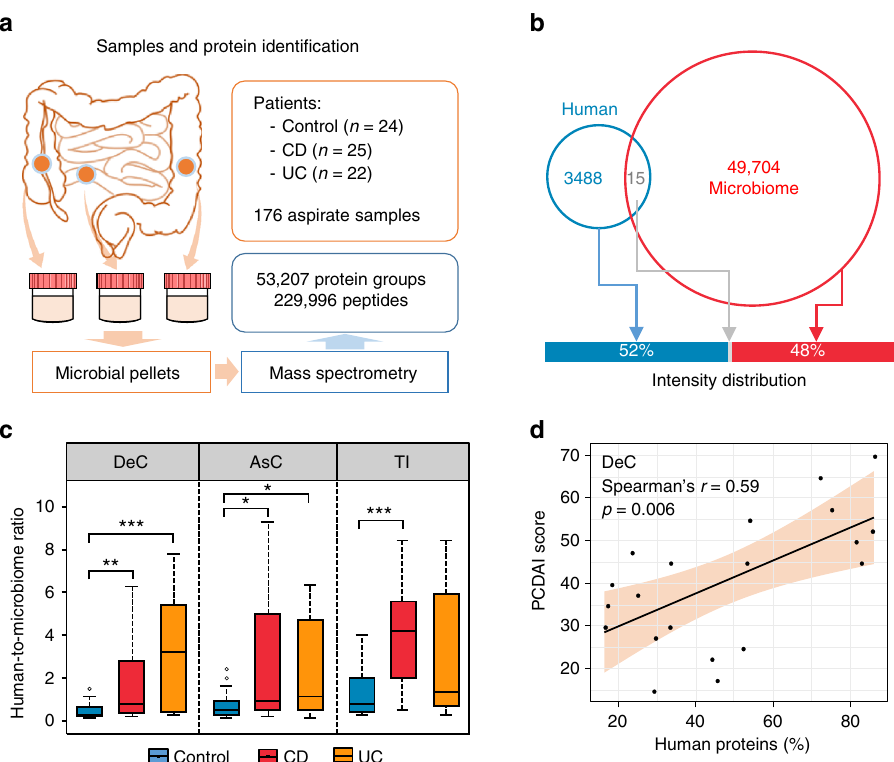
Fig. 1 Metaproteomics approach for assessing both human and microbiota proteins in intestinal aspirate samples. a Experimental work fl ow; b Distribution of quanti fi ed human- and microbiome-derived protein groups. Venn diagram indicates the numbers of quanti fi ed protein groups, while the bar graph shows the intensity of human or microbiome proteins. c Human-to-microbiome ratios of total protein intensity. For the box plot, the bottom and top of the box are the fi rst and third quartiles, respectively. The middle line represents the sample median. Whiskers are drawn from the ends of the interquartile range (IQR) to the furthest observations within 1.5 times the IQR range. Outliers >1.5 times the IQR are indicated with circle. * p < 0.05, ** p < 0.01, *** p < 0.001. d Representative scatter plot between the percentage of human proteins and CD disease severity